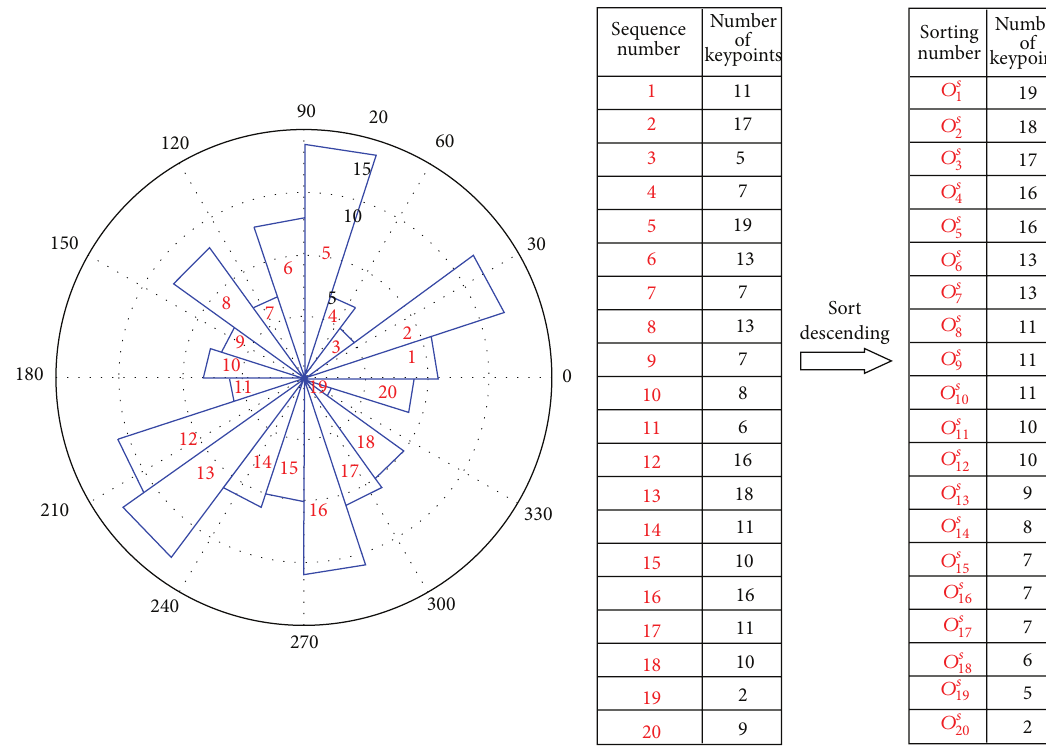
Figure 6: OPDF of keypoints’ primary